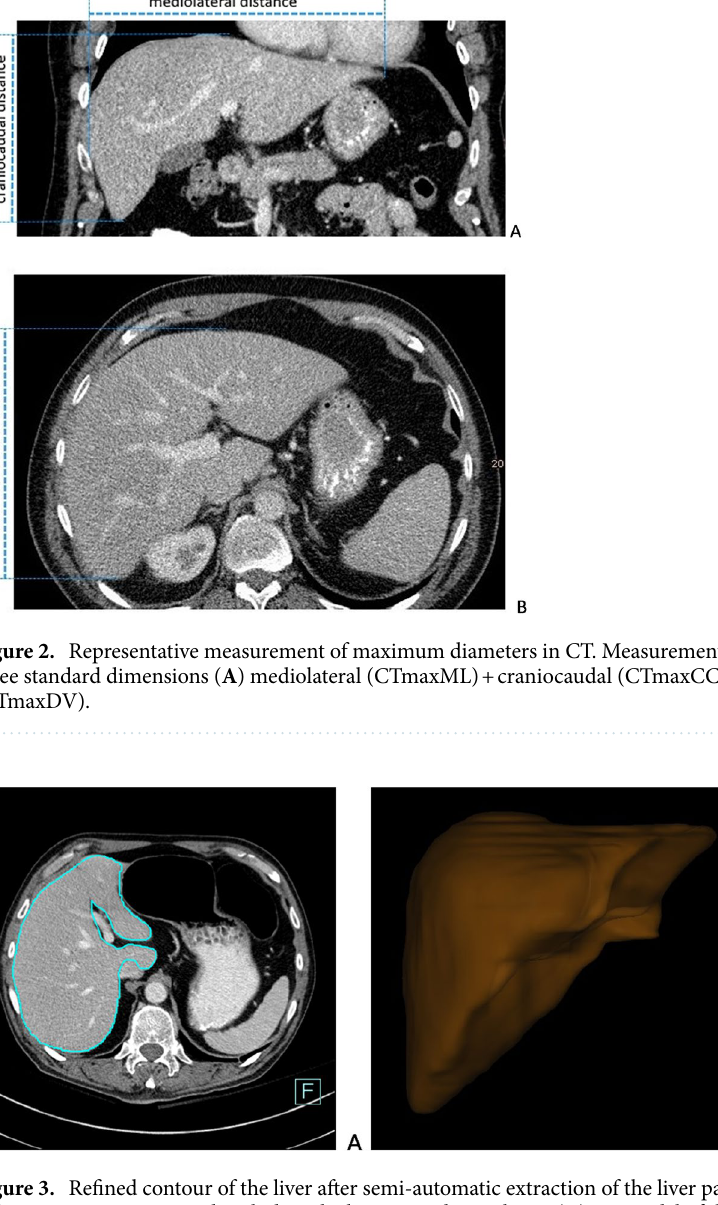
Figure 3. Refined contour of the liver after semi-automatic extraction of the liver parenchyma from abdominal CT-image in Syngo.Via and excluding the hepatic and portal vein ( A ) 3D model of the liver after post-processed liver shape ( B